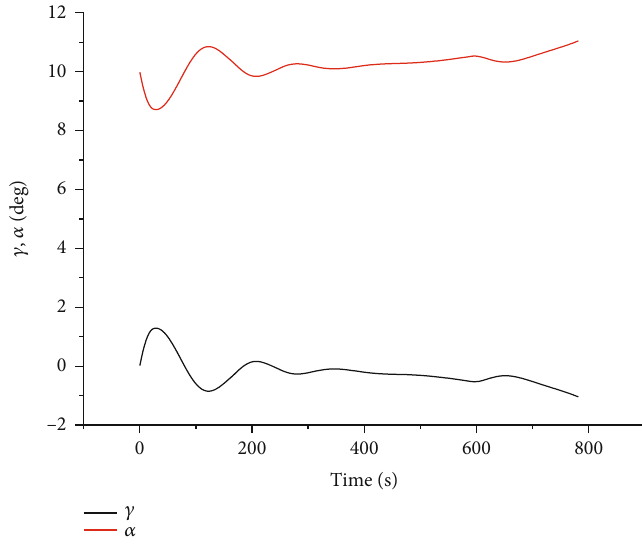
Figure 8: Elevation angle and angle of attack with constant pitch.